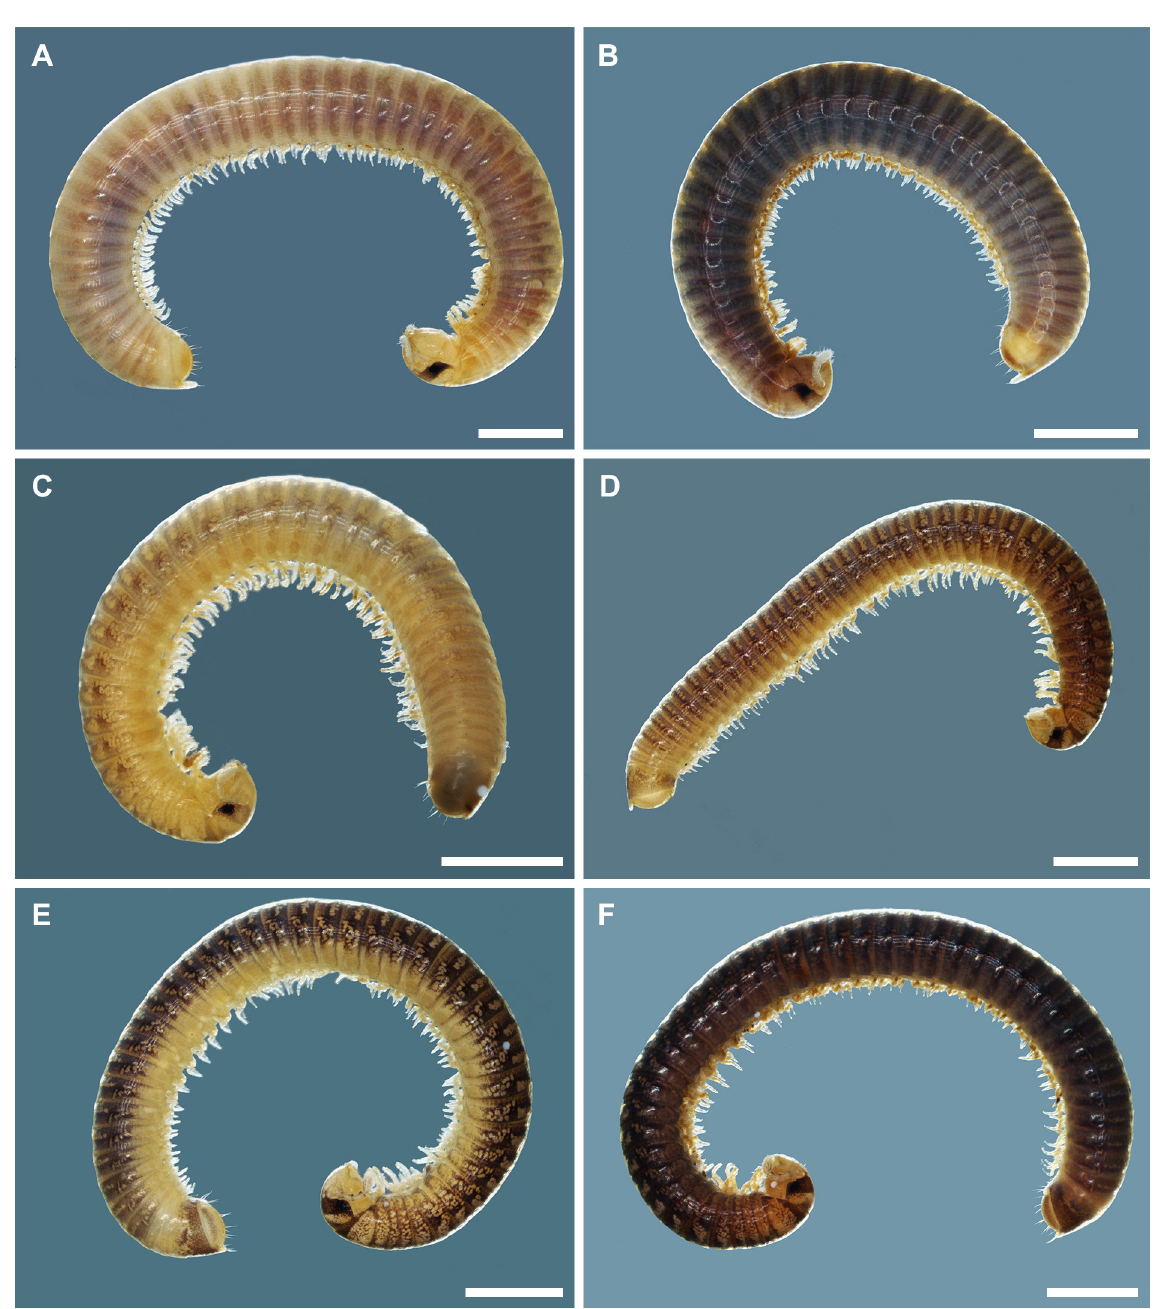
Fig. 30. Leucogeorgia oculata sp. nov., specimens from Lagonaki Plateau, habitus, lateral views. A . Largest paratype ♀ (ZMUM). B . Smallest paratype ♀ (ZMUM). C – F . Non-type ♂♂ (IZB). Scale bars: 1